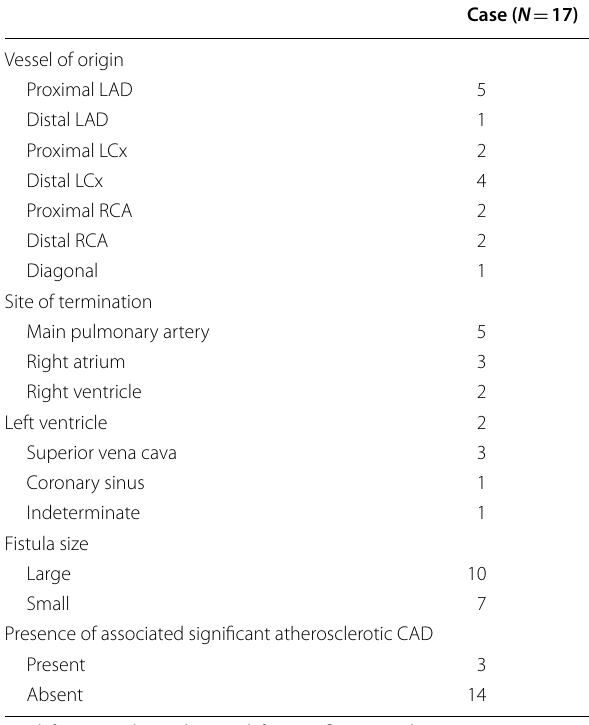
LAD left anterior descending, LCx left circumflex, RCA right coronary artery, CAD coronary artery